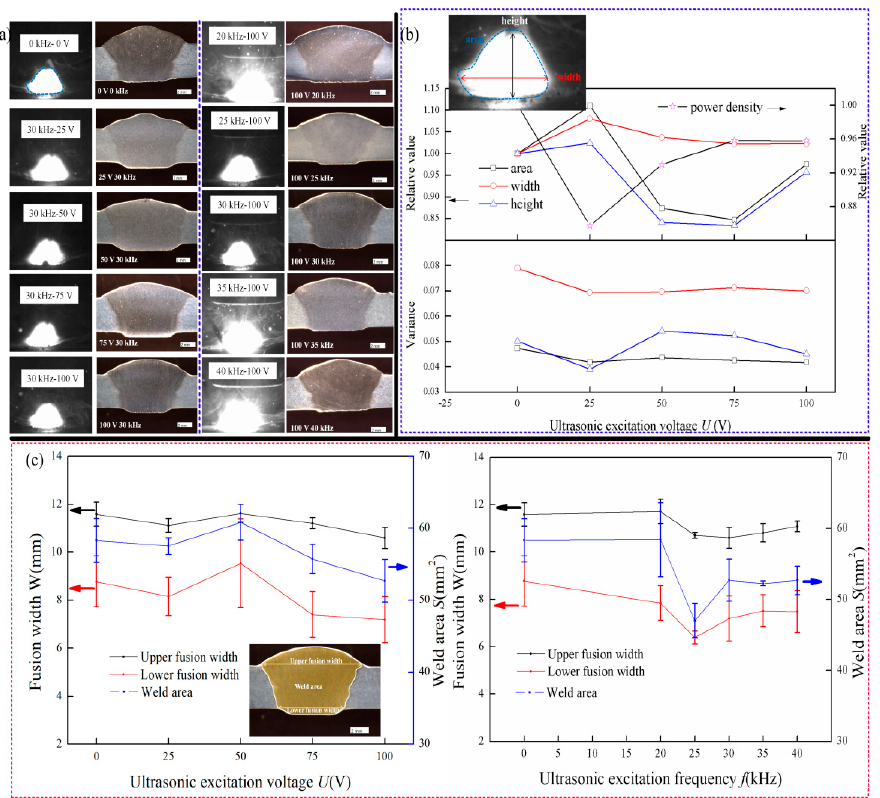
Figure 2. ( a ) Morphologies of the welding arc and weld formation, and ( b ) characteristics of welding arc, and ( c ) characteristics of fusion width and weld area. arc, and ( c ) characteristics of fusion width and weld